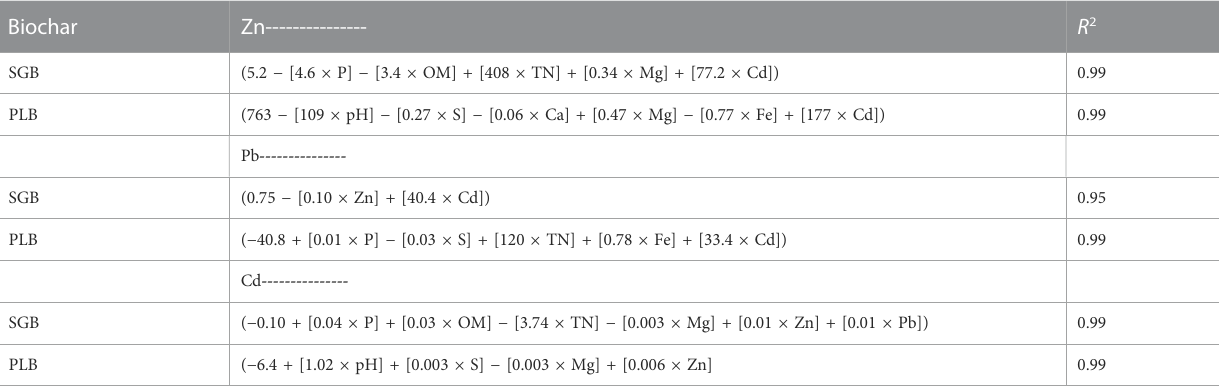
TABLE 3 Equations from stepwise multiple linear regression models (SMLR) based on the lowest adjusted Akaike information criterion ( AICc ).